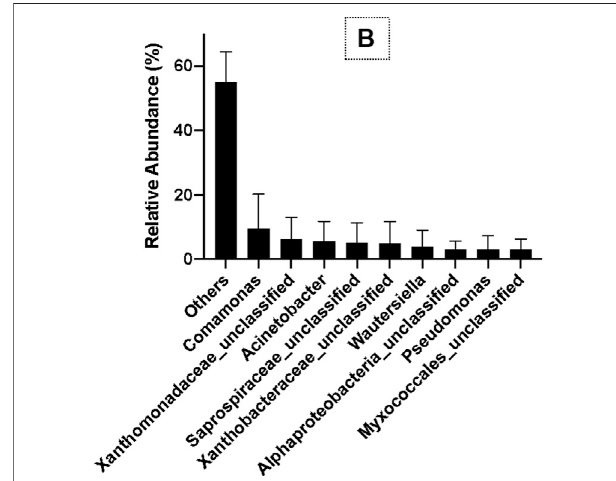
FIGURE 5 | Bacterial diversity at the class level (A) and the genus level (B) in SS by MiSeq sequencing.